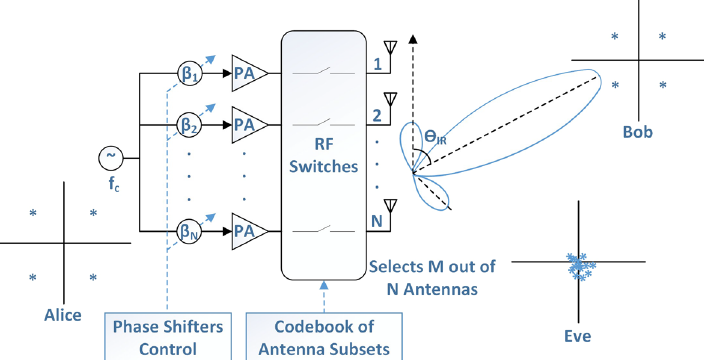
Fig. 5 Transmitter architecture of a typical angular DM for antenna subset based transmission is shown. Data constellations transmitted by Alice are correctly received in the direction of Bob. In the direction of Eve, however, constellations are distorted and randomly